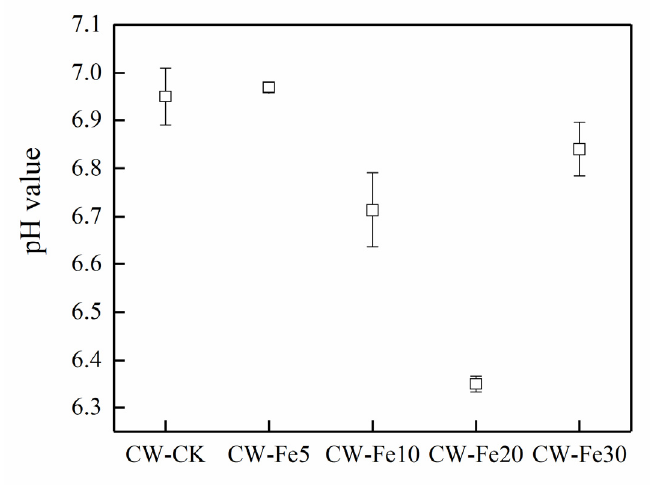
Figure 3. Changes of Fe 2 ( a ), total iron ( b ), and Fe 3+ ( c ) with HRT and influent Fe 2+ concentrations.